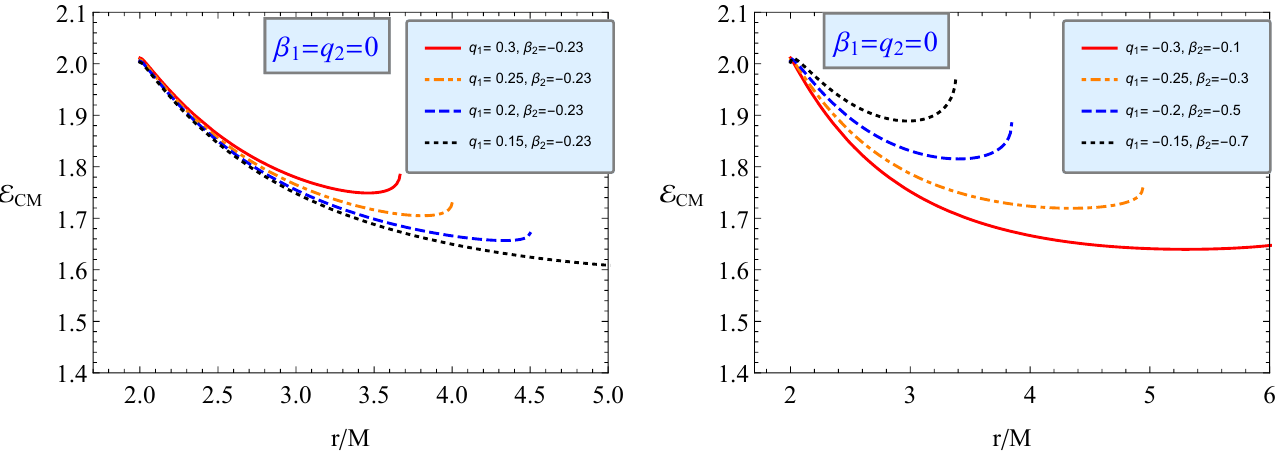
Figure 13. The same as Figure 9 but for collisions of positively charged particles with non-dipole- negative magnetized particles with no